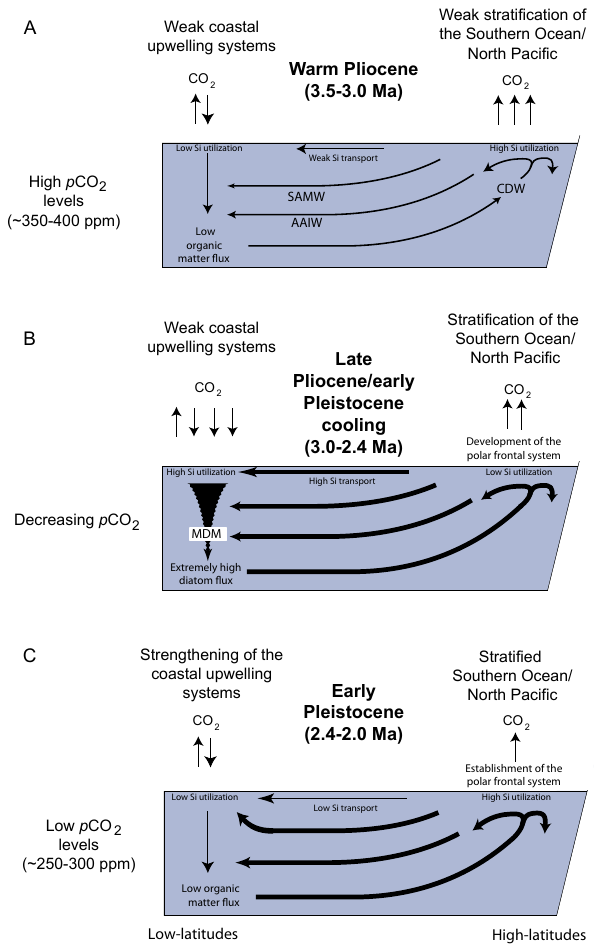
Fig. 5. Proposed scenario representing the Si transport from the Southern Ocean/North Pacific towards upwelling systems and its utilisation by phytoplankton productivity during (A) the warm Pliocene, (B) the Late Pliocene/Early Pleistocene cooling and (C) the early Pleistocene. CDW, Circumpolar Deep